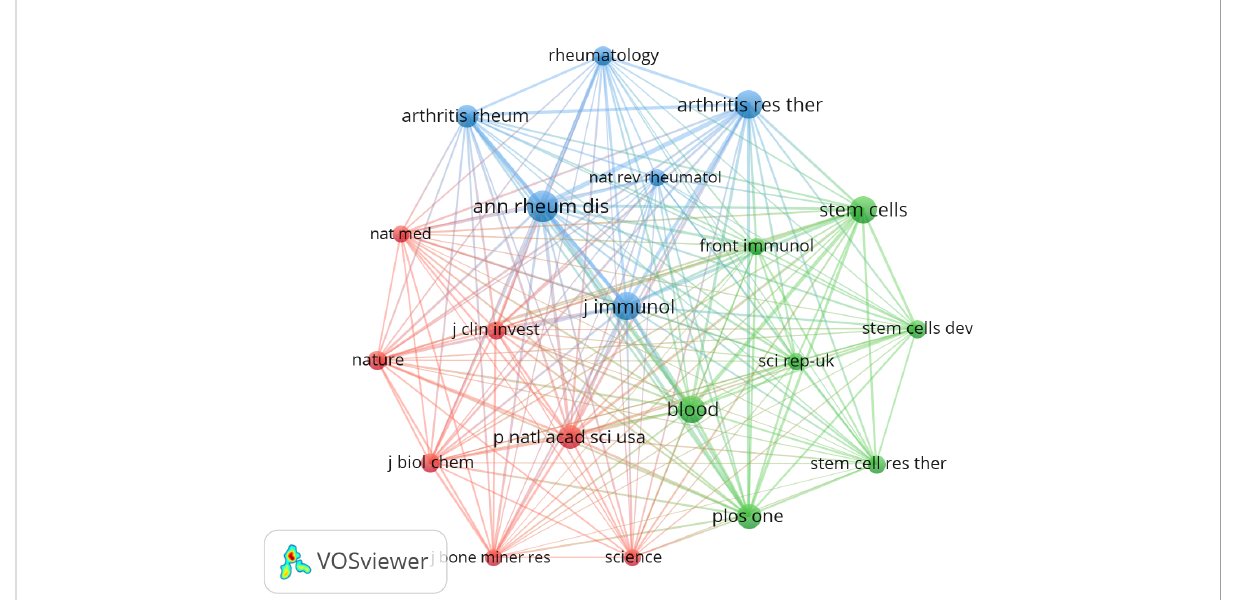
FIGURE 5 The visualization of co-cited journals on research of MSCs and RA.